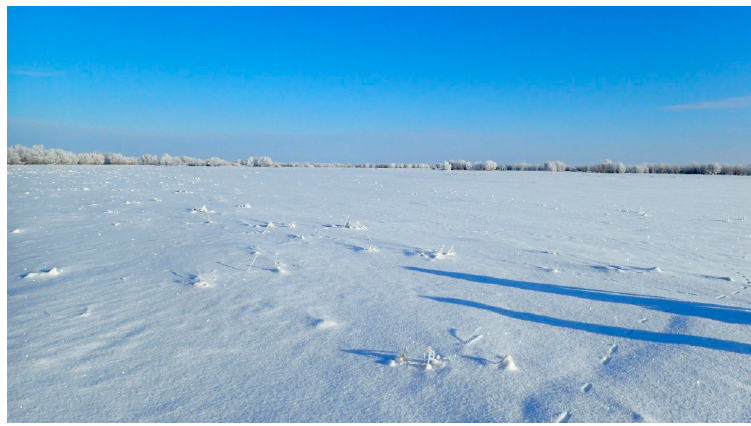
Figure 2. Sampling site 31 on a high floodplain on the left bank of the Ob river. Photo was taken by O.S. Pokrovsky.